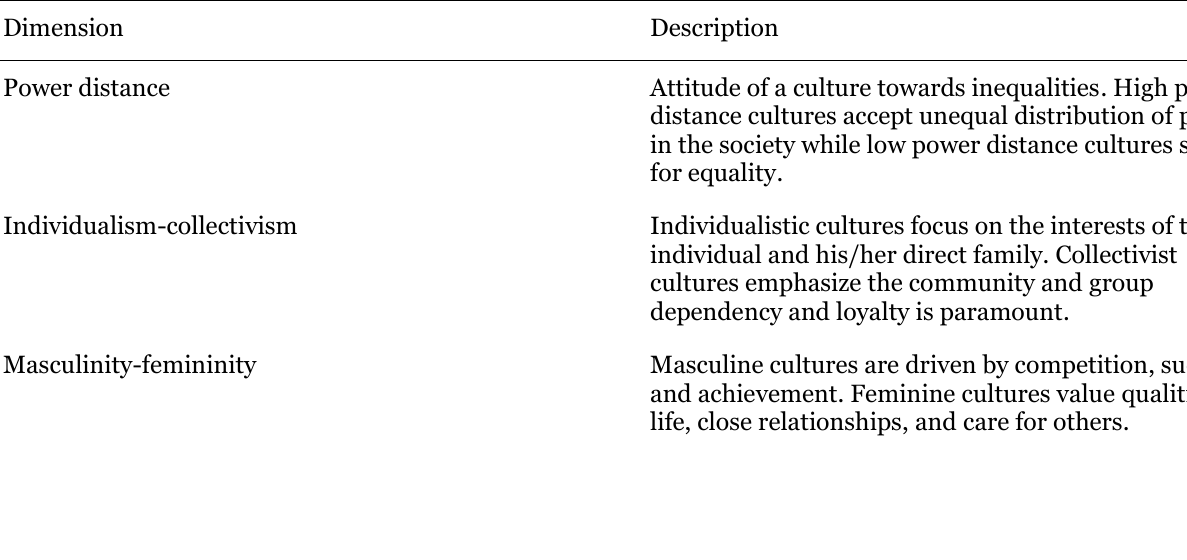
Summary of Hofstede’s Cultural Dimensions Employed in This Study Dimension Description Power distance Attitude of a culture towards inequalities. High power